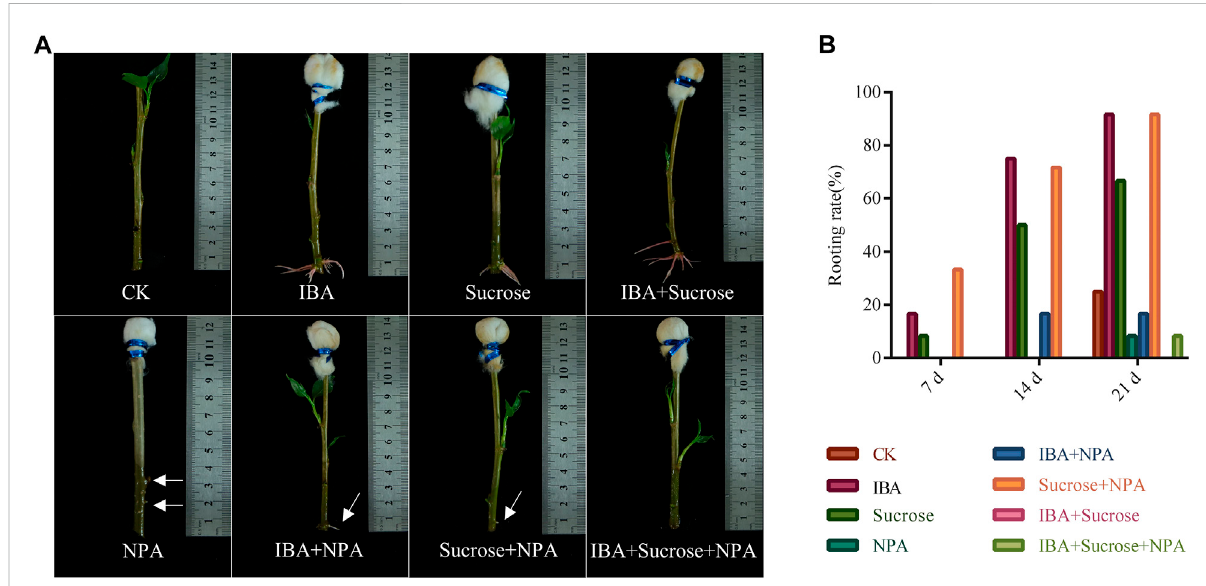
FIGURE 8 Effectsofamixtureofexogenousauxin,sucrose,andNPAonrootformationin P.xiaohei cuttings. (A) Mixtureofexogenousauxin,sucrose,and NPA was applied on the top of P. xiaohei cuttings for 14 days. (B) Rooting rate of P. xiaohei cuttings treated with a mixture of exogenous auxin, sucrose, and NPA for 7, 14, and 21 d, respectively. Values are from 12 independent cuttings. White arrows represent irregular bumps and unhealthy